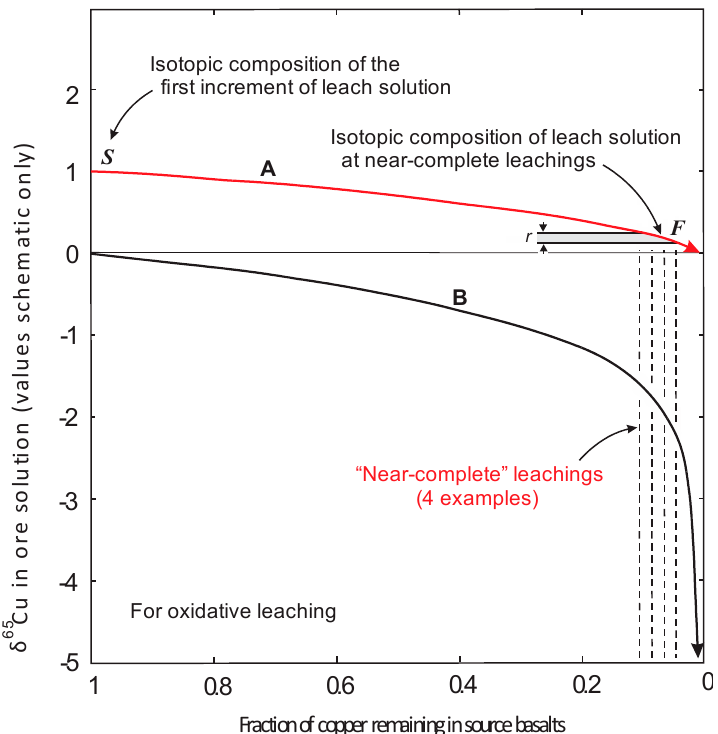
Figure 4. Representation of copper isotopic compositions during oxidative leaching, based on Rayleigh fractionations. Red arrow A shows the expected progression in δ 65 Cu values within the leach solutions, which initially would have been isotopically heavy (>0.8‰, according to Bornhorst and Mathur), and would then have trended toward lighter δ 65 Cu values because of the progressive oxidative leaching